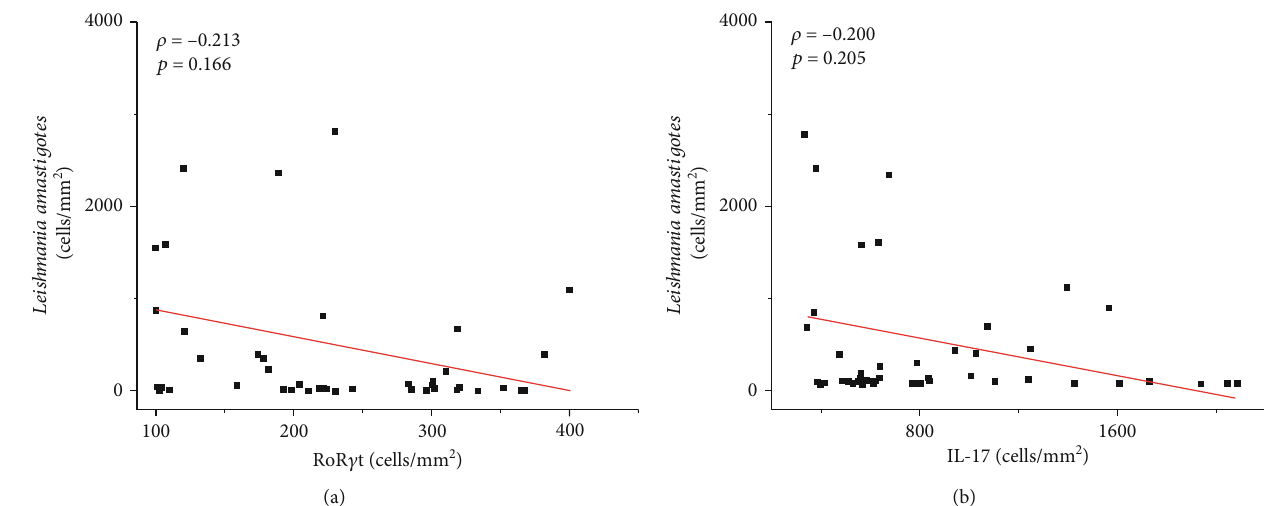
Figure 4: Graph showing the correlation between the density of Leishmania amastigotes and RoR γ t + cells (a) and IL-17 + cells (b). The value of ρ is Spearman ’ s correlation coe ffi cient, and p is the p value. The red line indicates a negative correlation.